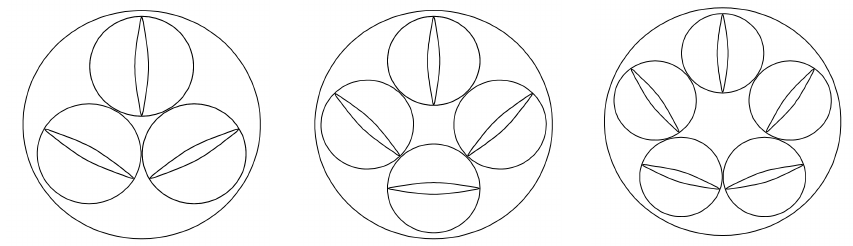
Figure 12. Different number of blades with the same outer